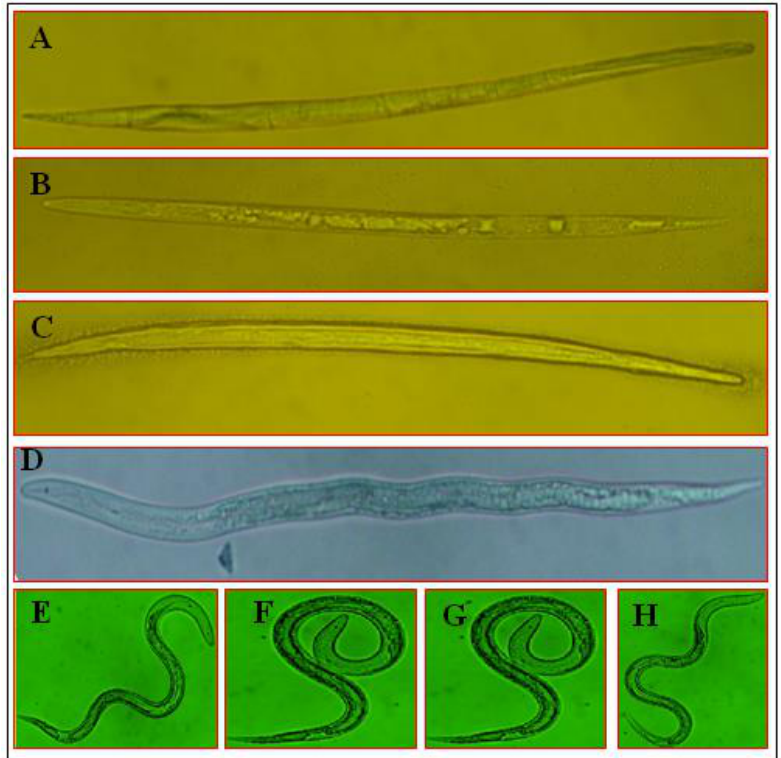
Figure 6. Morphological variations in M. incognita J2s treated with SMs of T. viridae obtained on different growth media. ( A ) Abamectin (positive control); ( B ) STP; ( C ) Solid; ( D ) MOF; ( E ) MMK2; ( F ) SuM; ( G ) methanol; ( H ) water (negative control). Bar = 300 μm.